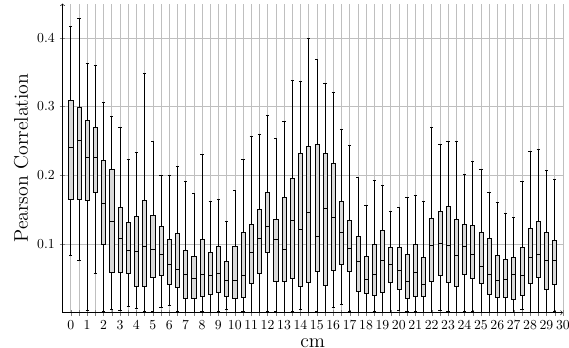
Figure 6: Correlation over distance for a potential